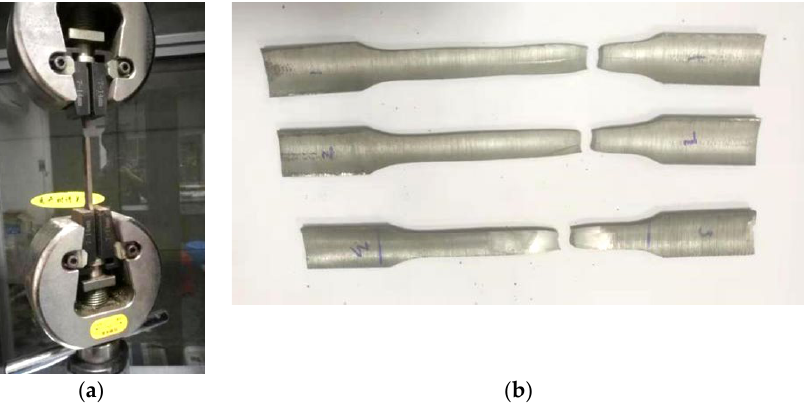
Figure 7. Uniaxial tension tests of dog-bone-shaped specimens: ( a ) loading equipment and ( b ) failure mode. Table 1. Material properties of the sleeve.